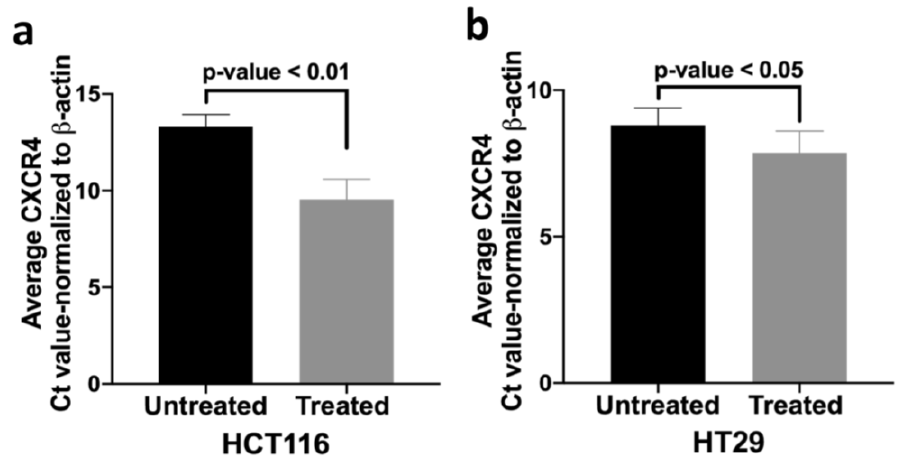
Figure 5. Demethylating agent 5-aza-2’deoxycytidine increases CXCR4 transcript abundance. RT-PCR results display a decreased normalized Ct value (average) and therefore reflects the increased CXCR4 mRNA expression in colorectal cancer cell lines ( a ) HCT116 and ( b ) HT29 after treatment with 5 µ M concentration of demethylating agent